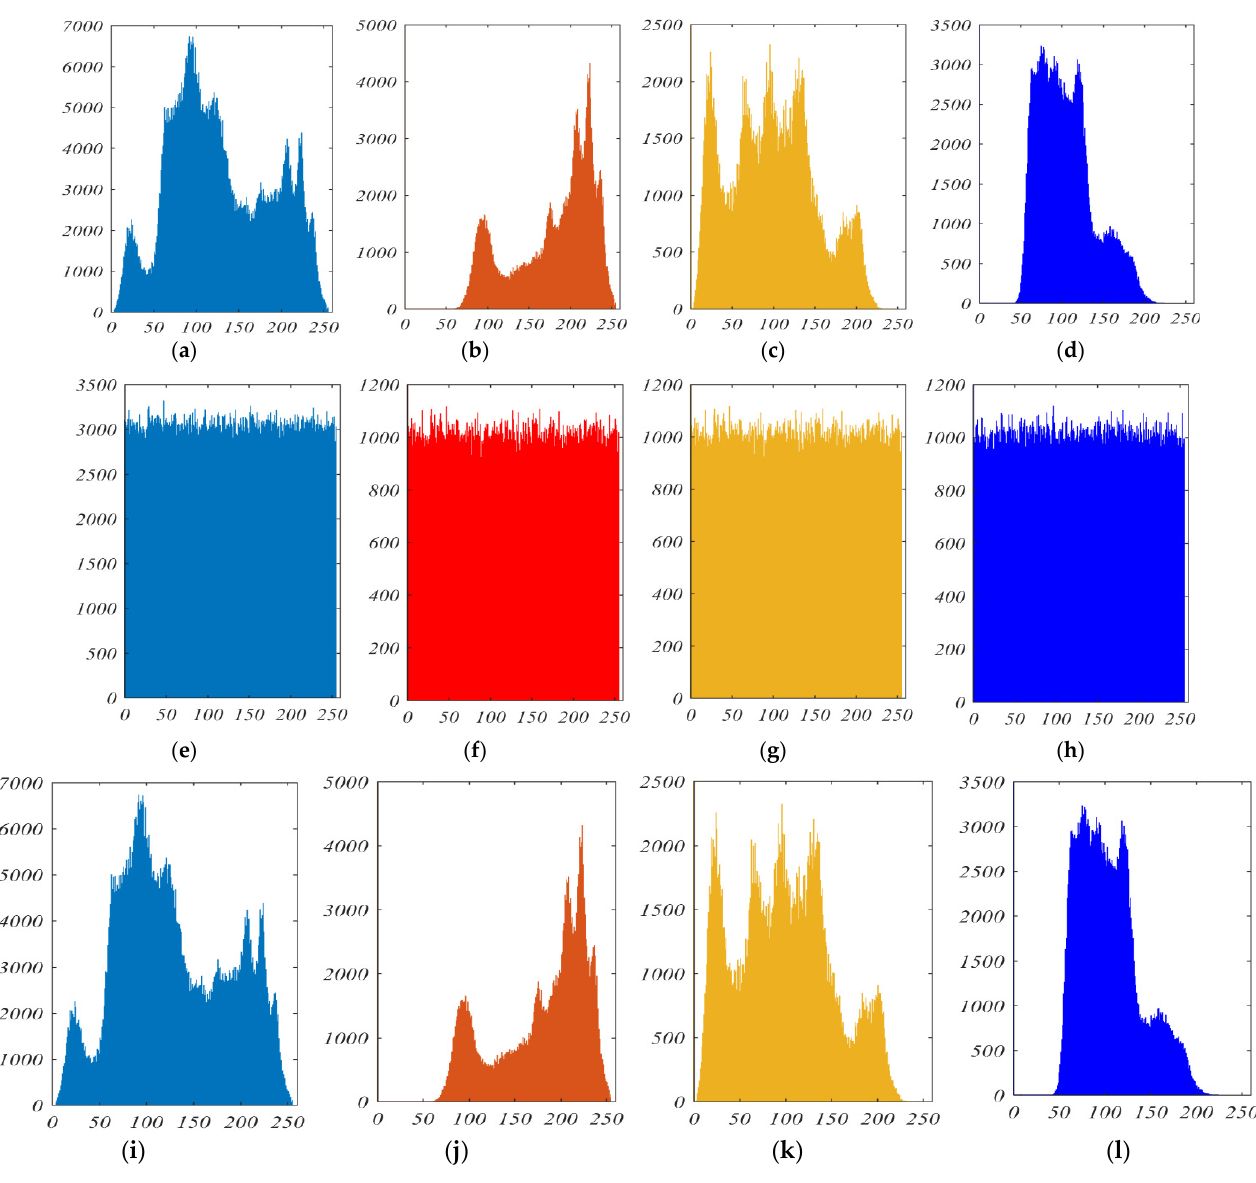
Figure 16. The histogram of a Lena image: ( a ) plain image, ( b ) R band, ( c ) G band, ( d ) B band, ( e ) encrypted image, ( f ) encrypted R band, ( g ) encrypted G band, ( h ) encrypted B band, ( i ) recovered image, ( j ) recovered R band, ( k ) recovered G band, ( l ) recovered B band.